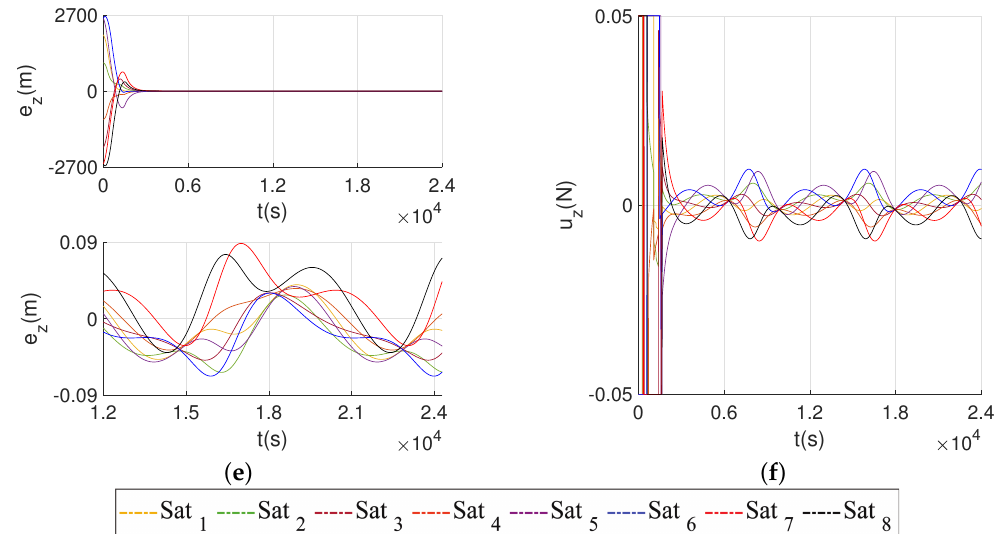
Figure 15. PBC law. Error and control time histories: ( a ) errors along axis x; ( b ) controls along axis x; ( c ) errors along axis y; ( d ) controls along axis y; ( e ) errors along axis z; ( f ) control along axis